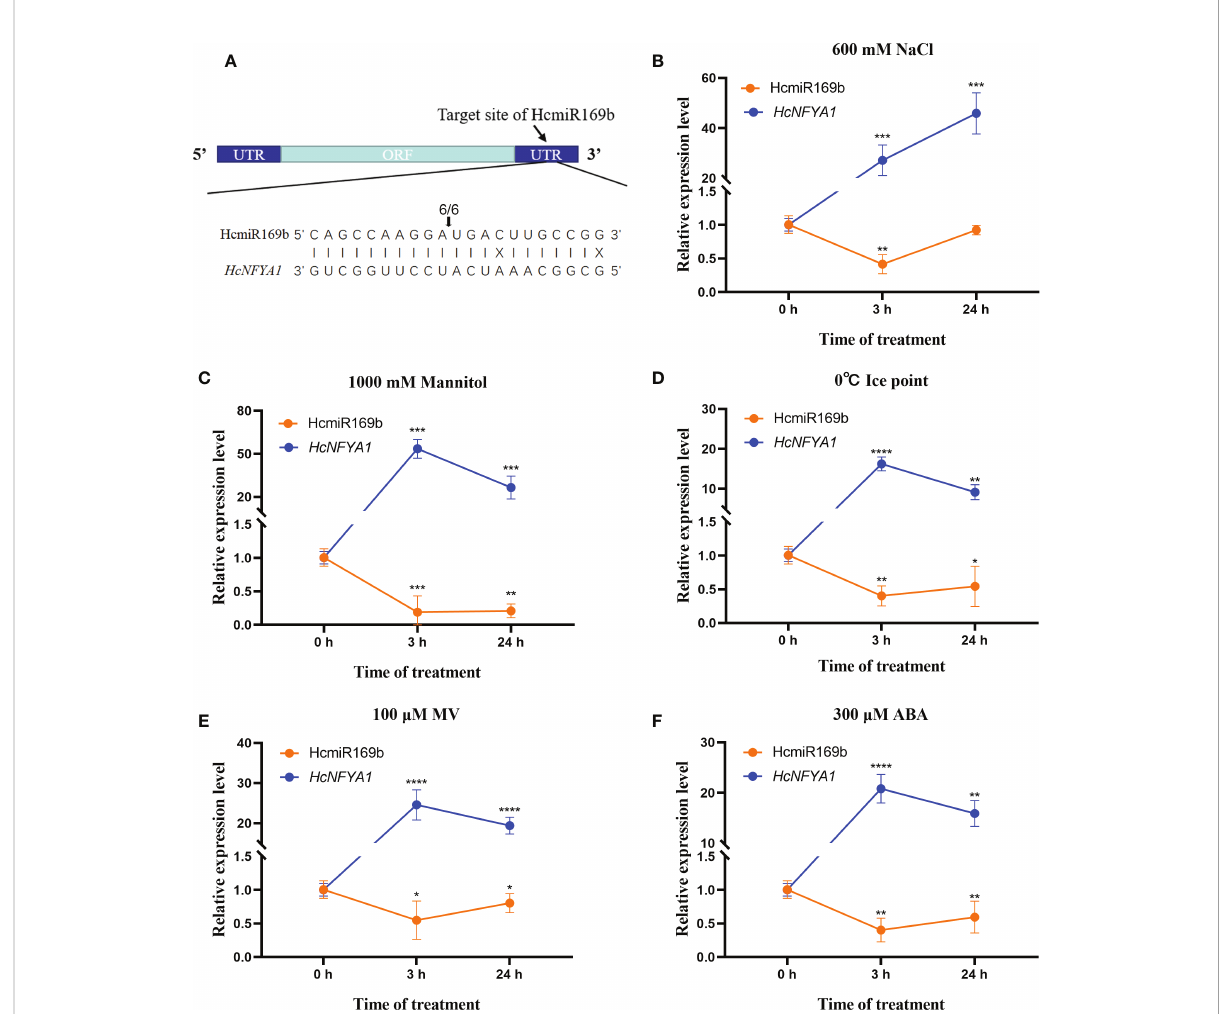
FIGURE 1 Targeting relationship between Halostachys caspica miR169b and NFYA1 and the expression patterns of both genes under abiotic stress. (A) RLM-RACE identi fi ed the targeted cleavage of HcNFYA1 by HcmiR169b. Arrows indicated speci fi c cleavage site, and the number on the arrow indicated the number of independent clones for detecting the cleavage site. (B-F) The expression of mature miR169b and NFYA1 in assimilating branches of Halostachys caspica under salt (B) , simulated drought (C) , cold (D) , oxidative stress (E) and exogenous hormone ABA (F) . HcU6 and HcUBQ10 were used as internal controls. All data were represented as the means ± SD of three biological replicates. Asterisks